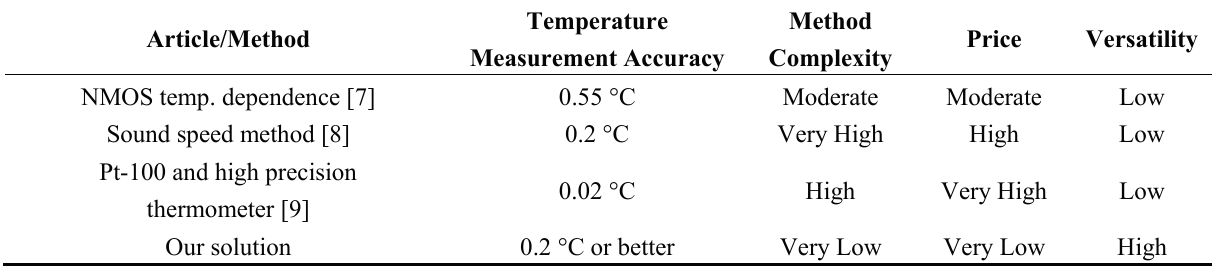
Table 1. Comparison of the existing method for precise temperature